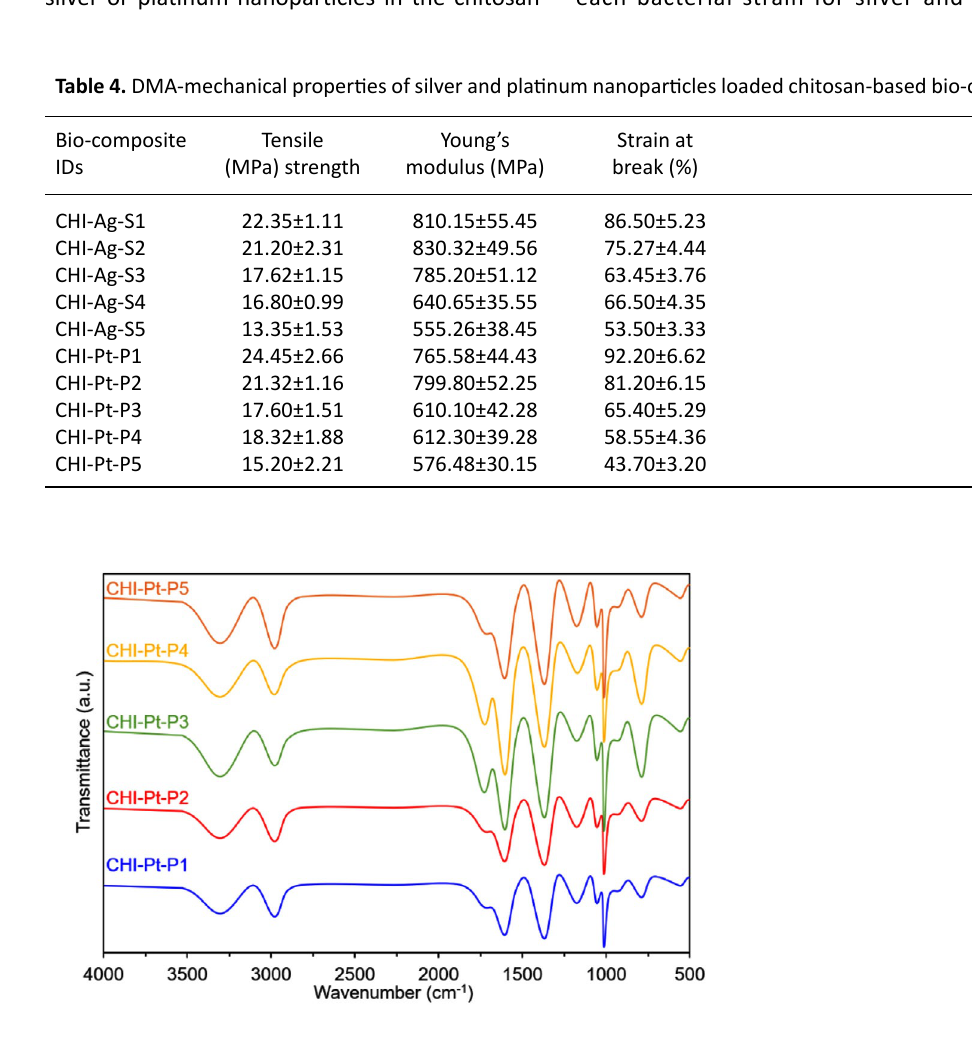
Fig. 9 Typical FTIR profiles of platinum nanoparticles loaded